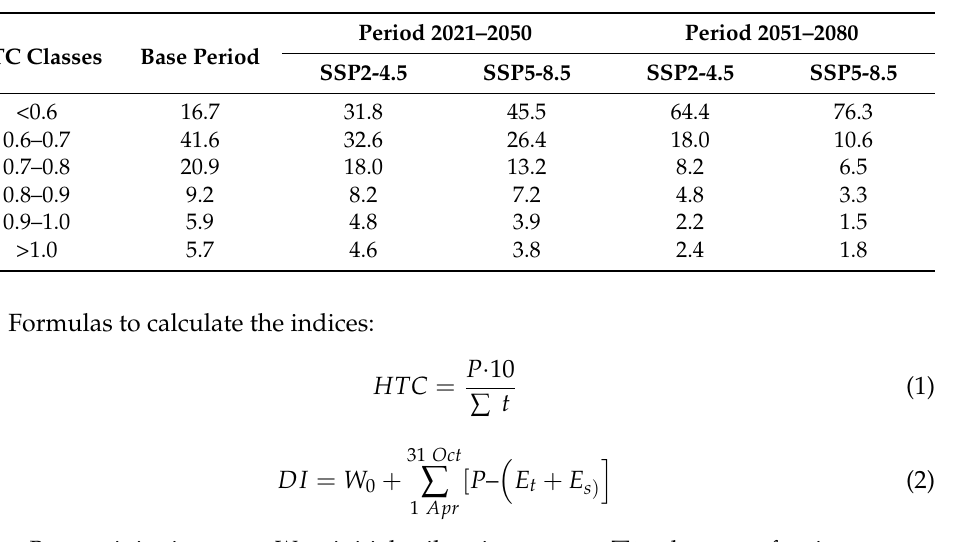
Table 2. Distribution of the area (in %) occupied by the different HTC intervals.